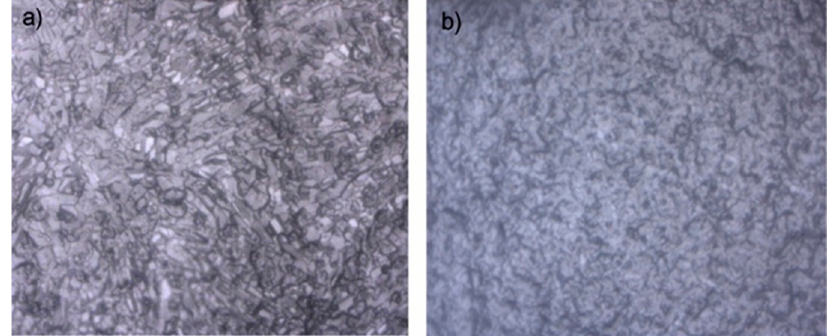
Figure 5. Microscopic pictures of hydrates crystals formed ( a ) in the open system and ( b ) in the closed system at t = 30 min after initial pressurization.